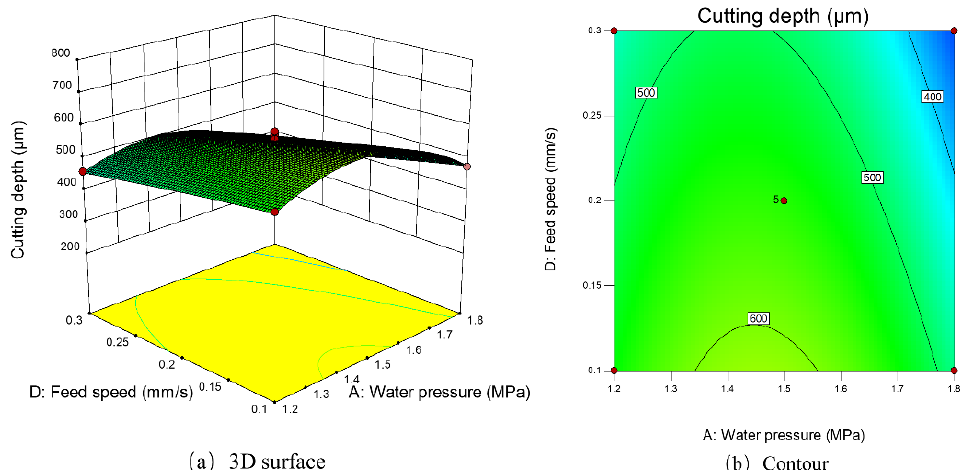
Figure 17. The 3D surface and contour map of the influence of feed speed and water pressure on cutting depth.